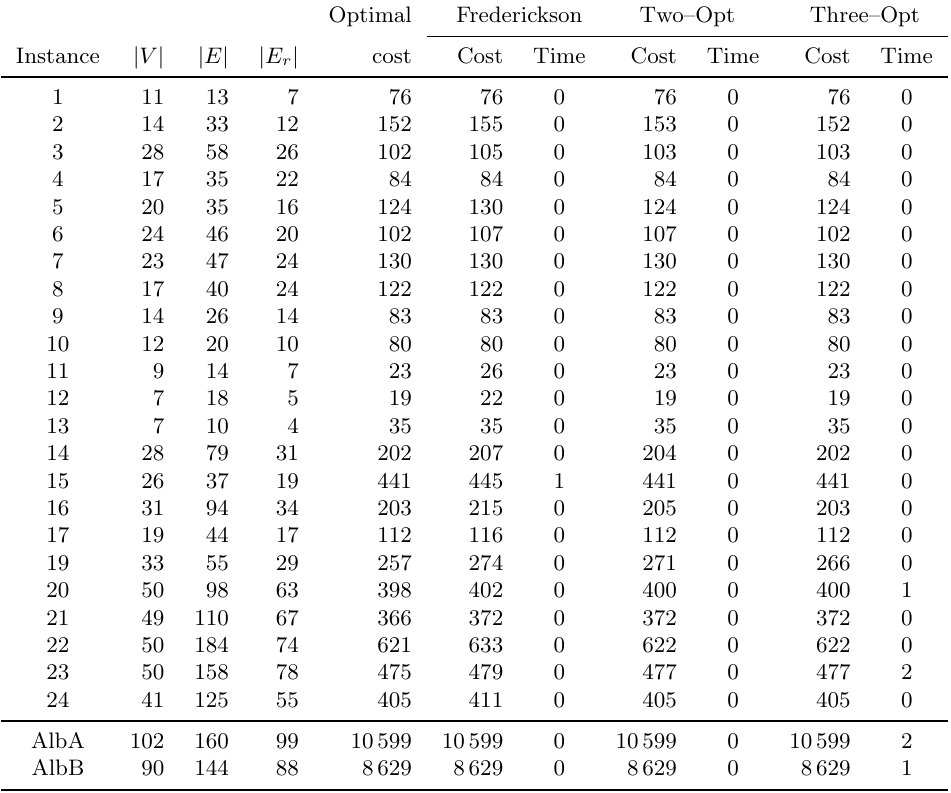
Table 1: Results for RPP benchmark test instances. Execution times are measured in seconds and were achieved on an Intel Pentium IV processor (2.8 GHz) with 512 Mb